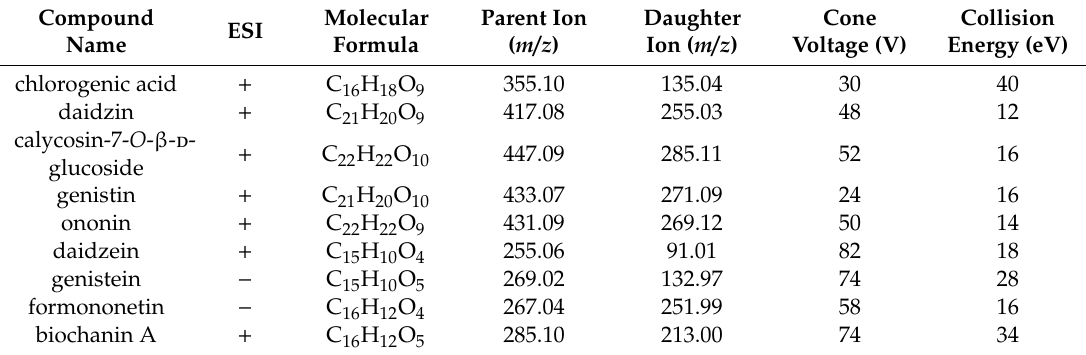
Table 3. The other parameters of the mass spectrometer were as follows: electrospray ionization source ◦ (ESI source); ion source temperature, 150 C; capillary voltage, 0.5 kV; desolvating gas, N 2 , flow rate, ◦ 1000 L / h; desolvating temperature, 500 C. Table 3. Mass spectrometry parameters of the nine detected